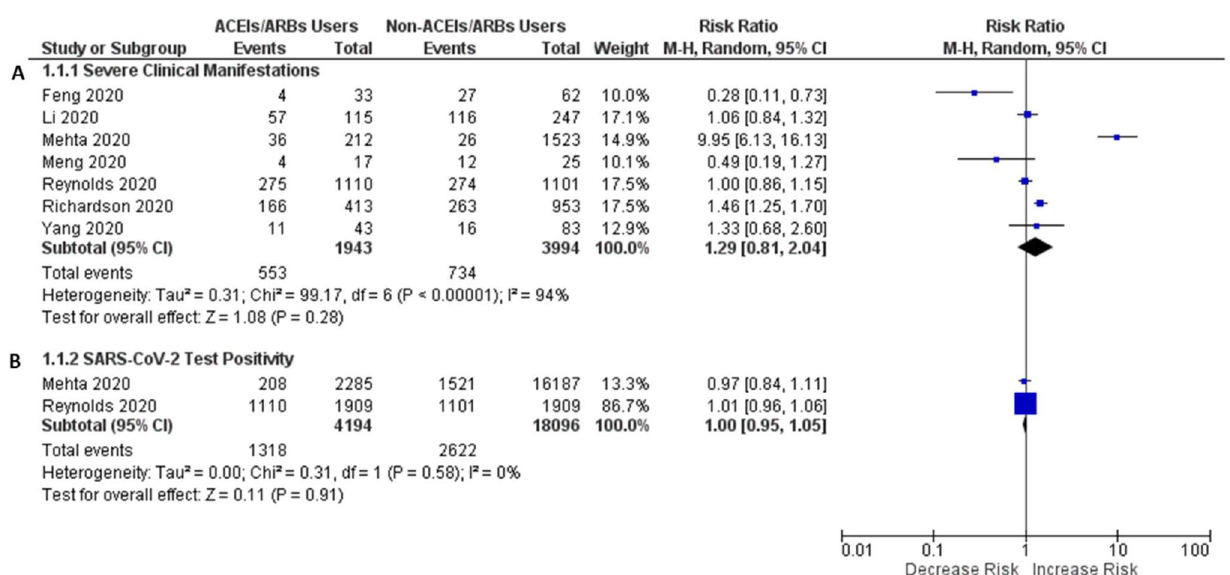
Figure 3. Forest plot of ACEIs/ARBs users against non-users of ACEIs/ARBs on the risk of severe clinical manifestations ( A ) and SARS-CoV-2 test positivity ( B ) in patients with